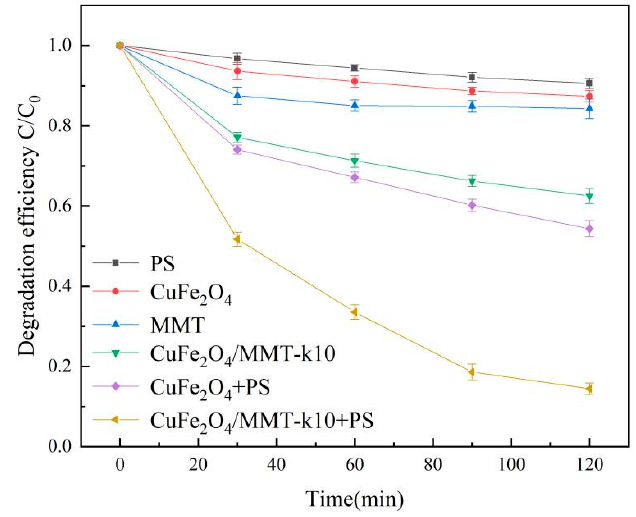
E ff ects of di ff erent reaction systems on the removal of LVF. Reaction conditions: Figure 6. Effects of different reaction systems on the removal of LVF. Reaction conditions: C 0 [LVF] = C 0 [LVF] = 10 mg / L, C 0 [persulfate (PS)] = 1.0 g / L, C 0 [catalyst] = 1 g / L, T = 25 ◦ C and initial 10 mg/L, C 0 [persulfate (PS)] = 1.0 g/L, C 0 [catalyst] = 1 g/L, T = 25 °C and initial pH = 6 (unadjusted). pH = 6